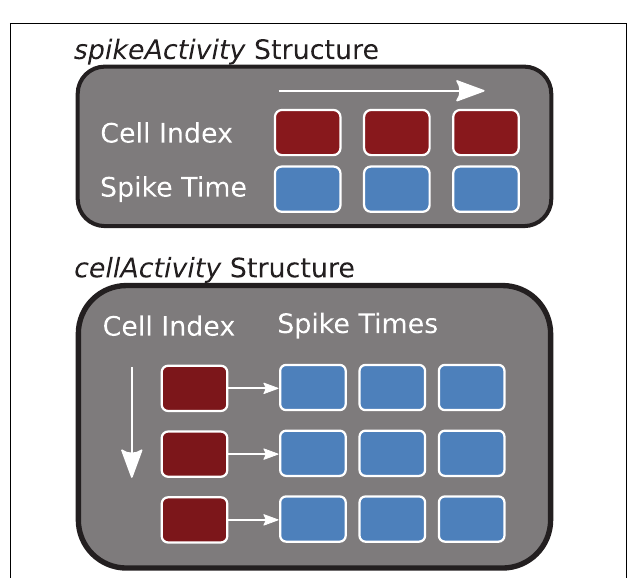
FIGURE 3 | Core Data Structures (C ++ ). The spikeActivity , top, stores sorted pairs of spikes times and cell indexes in a vector. The cellActivity structure is two-dimensional vector containing spike times for each of the